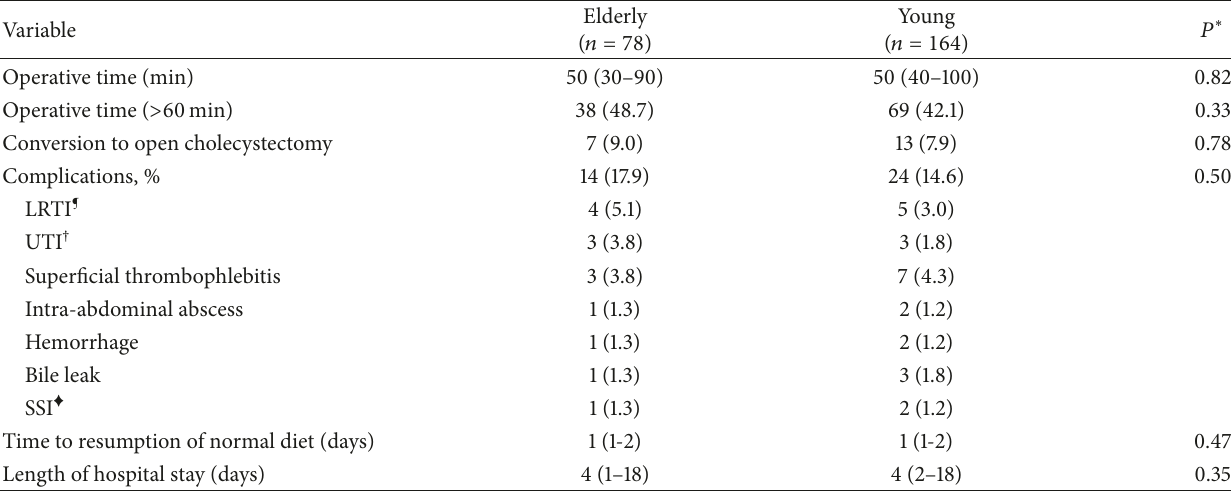
Table 3: Intraoperative and postoperative